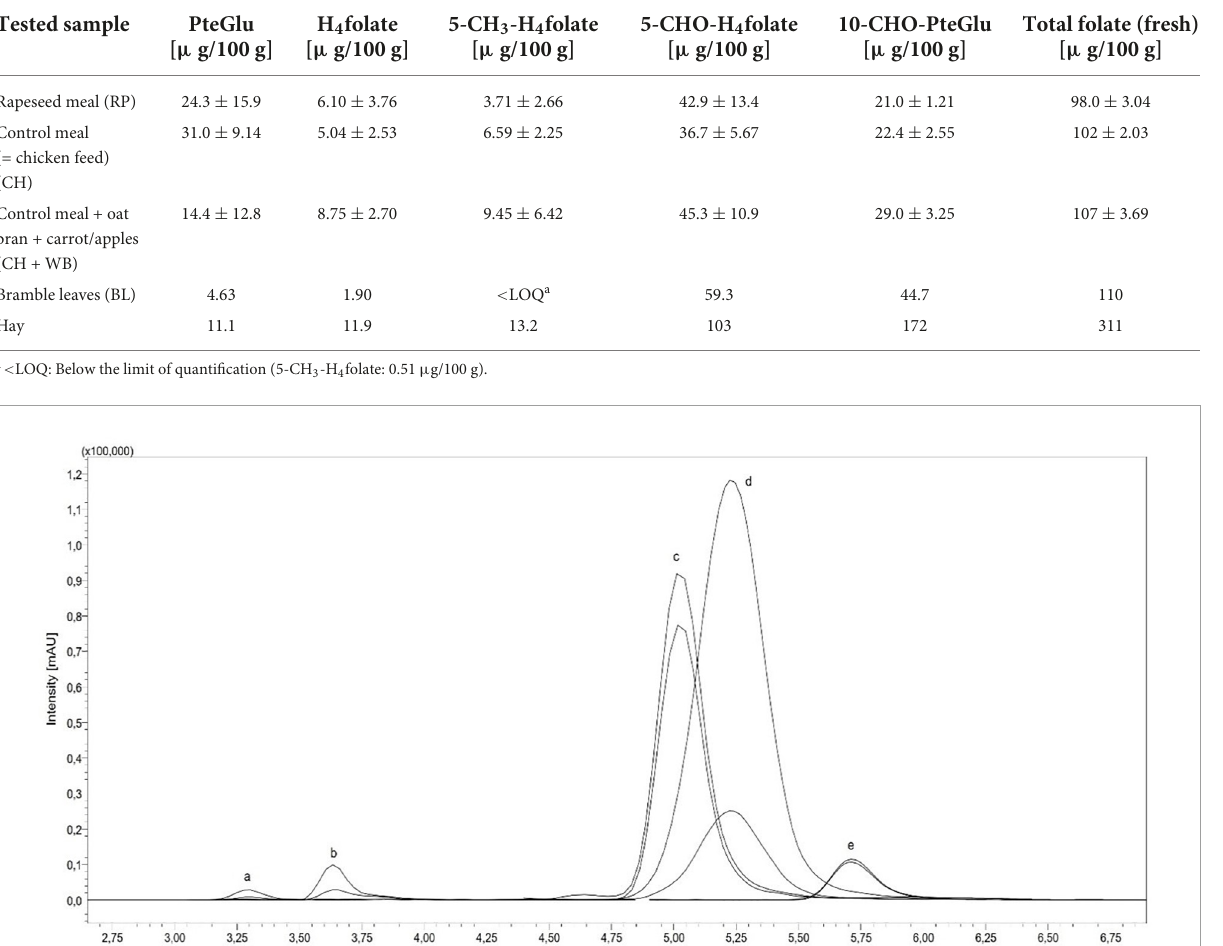
TABLE 2 Total folate content and vitamer distribution in feedstuffs, calculated as PteGlu [ µ g/100 g].